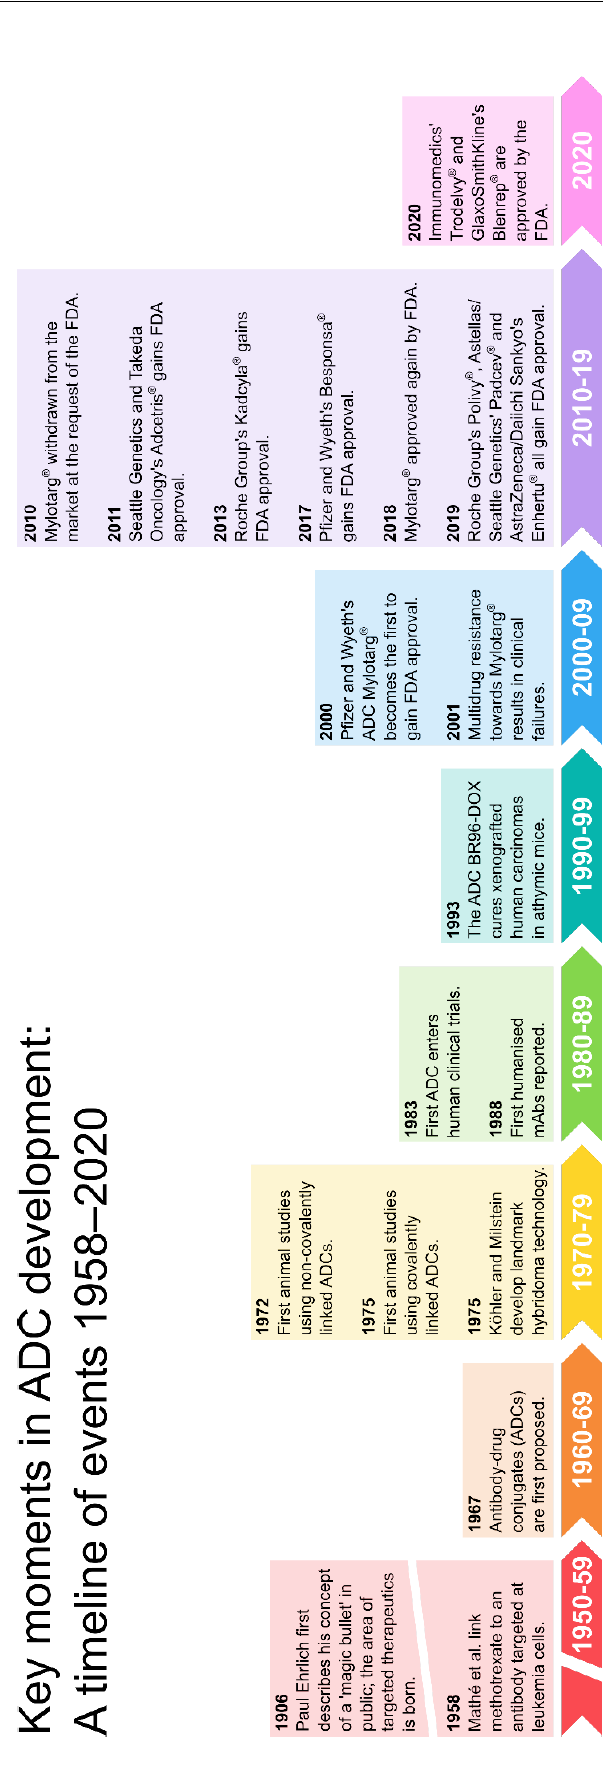
Figure 1. The evolution of ADC therapies. Figure redrawn based on the work of Perez et al. [7].